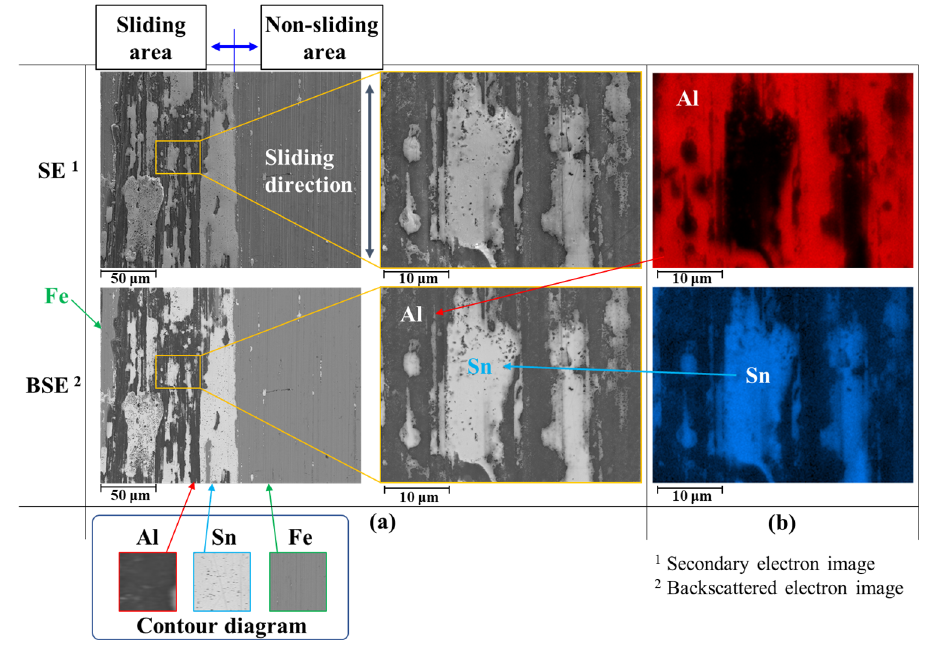
Figure 16. EDX analysis of steel journal surface after occurrence of seizure. ( a ) Low- to high- magnification electron microscopy images. ( b ) High-magnification elemental analysis results after seizure occurred.